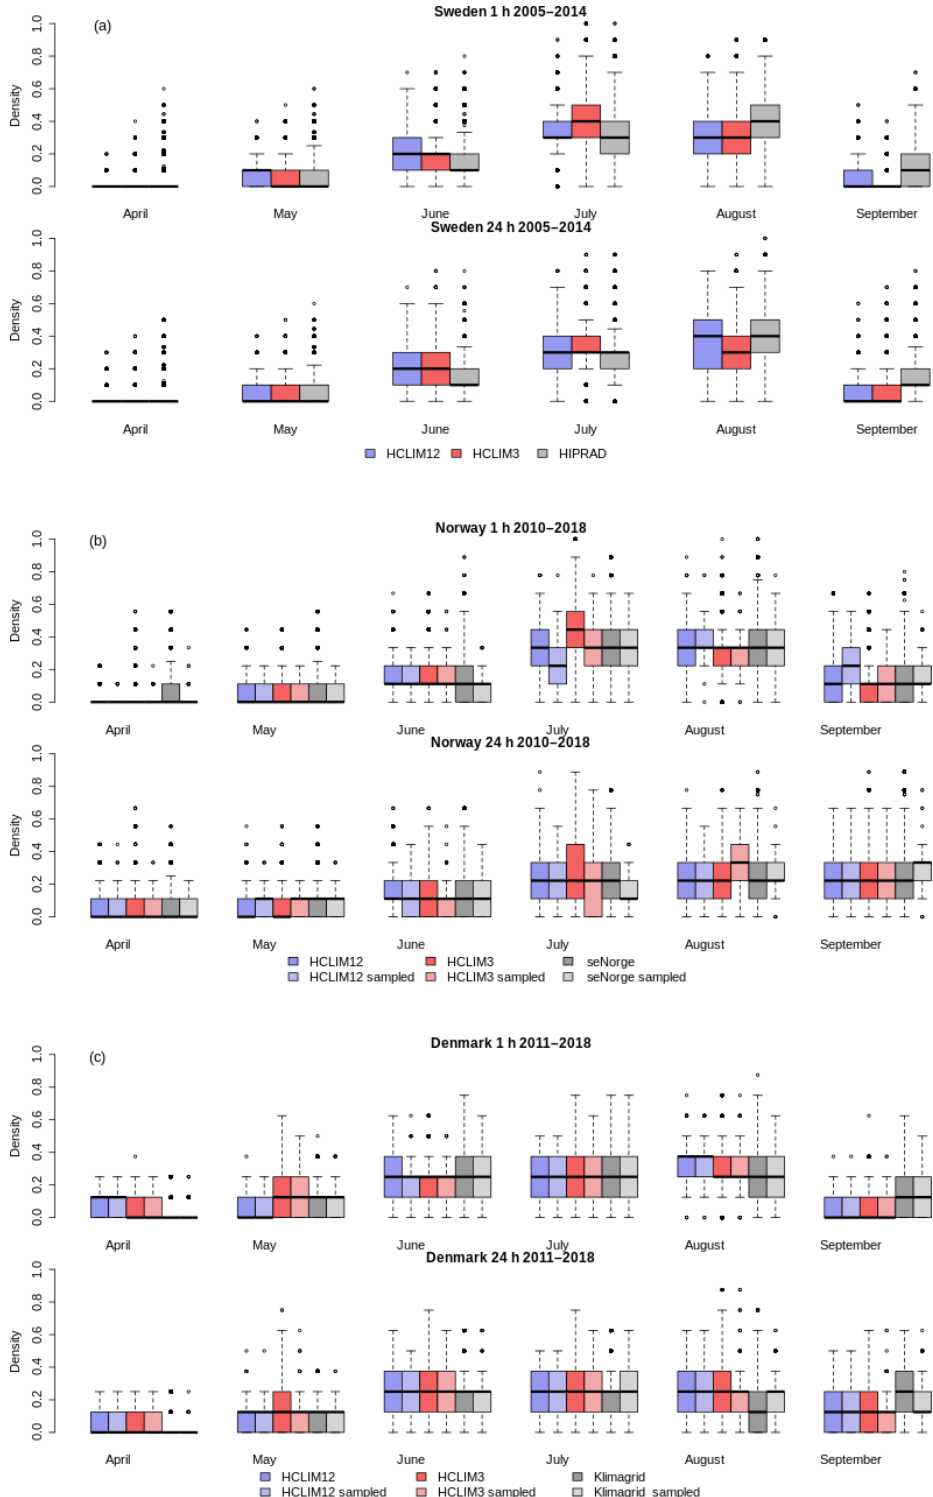
Figure 9. Same as for Fig. 3 but for the distribution of monthly occurrences based on hourly and daily annual maximum precipitation in (a) Sweden, (b) Norway, and (c) Denmark in HCLIM12, HCLIM3, and observational datasets. The label of sampled refers to the results with geographic